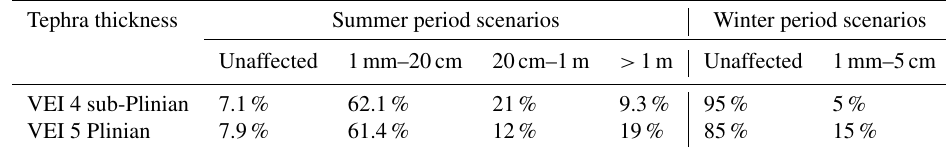
Table 2. Percentage of buildings affected by tephra fallout from VEI 4 sub-Plinian and VEI 5 Plinian eruption scenarios in the summer and winter